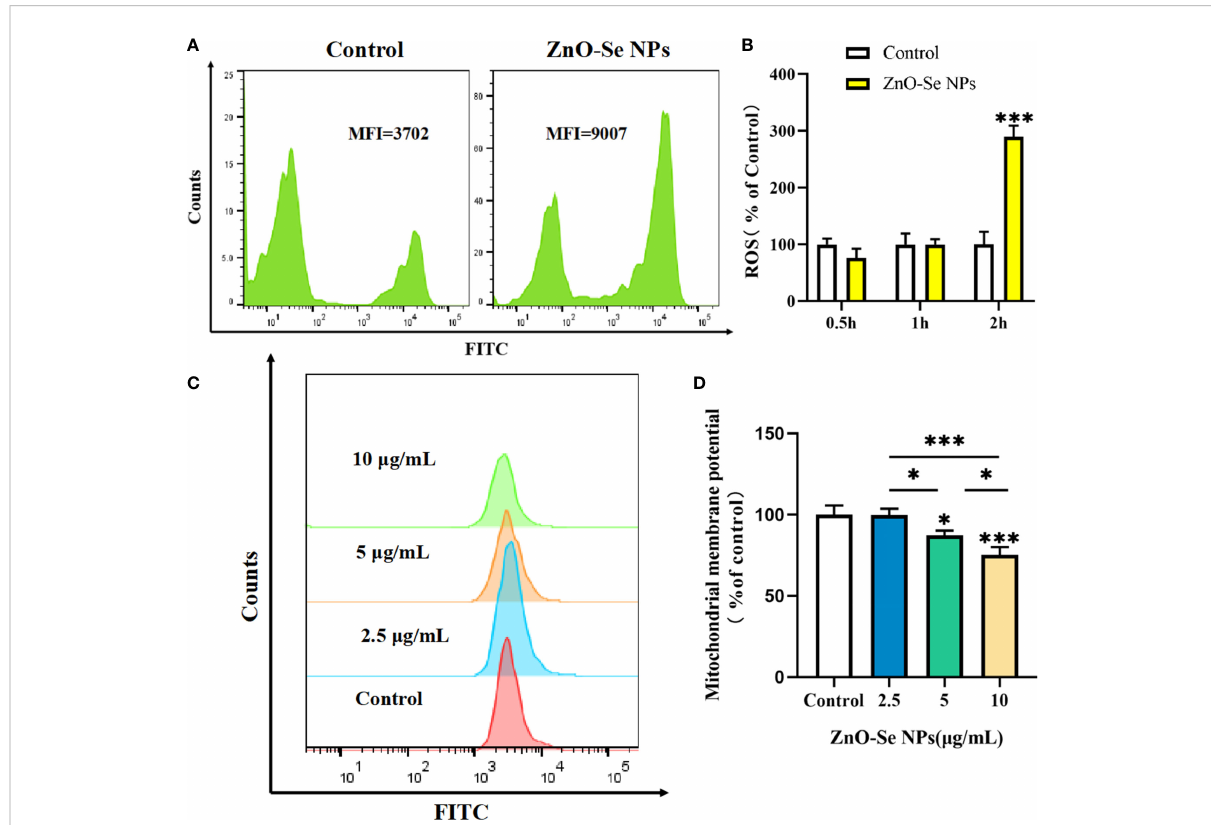
FIGURE 6 ZnO-Se NPs induce autophagy and apoptosis in Mtb infected macrophages by increasing intracellular ROS level and disrupting mitochondrial membrane potential. (A) Typical fl ow cytometry analysis of ROS level for BCG infected THP-1 cells before and after 2.5 m g/mL ZnO-Se NPs treatment. (B) Statistical results of ROS level for BCG infected THP-1 cells before and after ZnO-Se NPs treatment, n=3, ***p<0.001. (C) Typical fl ow cytometry analysis of mitochondria membrane potential for BCG infected THP-1 cells before and after ZnO-Se NPs treatment. (D) Statistical results of mitochondria membrane potential for BCG infected THP-1 cells before and after ZnO-Se NPs treatment, n=3, *p<0.05, ***p<0.001.